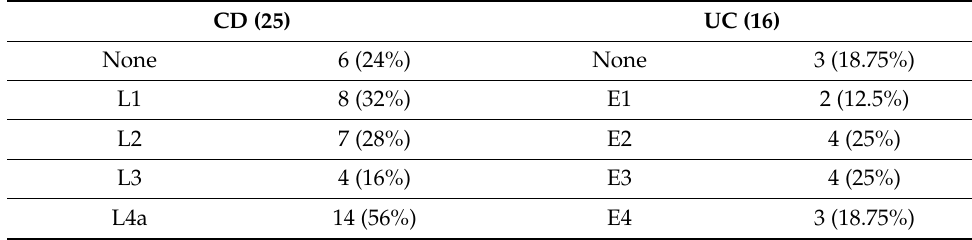
Table 1. Paris classification: disease